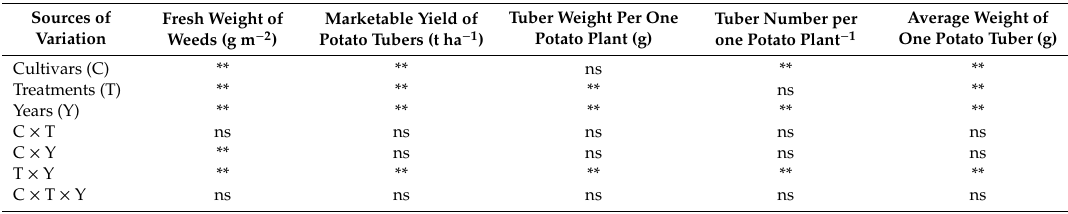
Table 5. Analysis of variance for fresh weight of weeds and the marketable yield of potato tubers and components of potato yield.